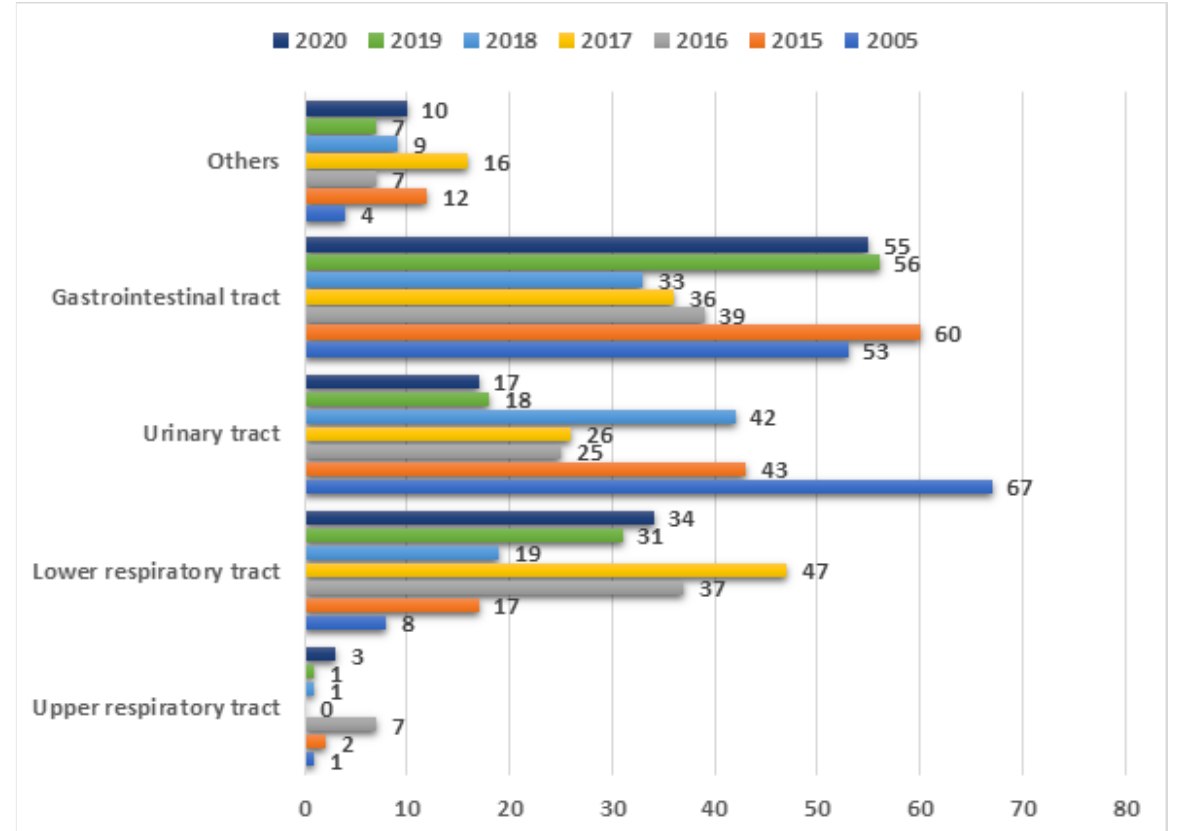
Figure 3. Samples collected in the NICU divided into 5 source groups.